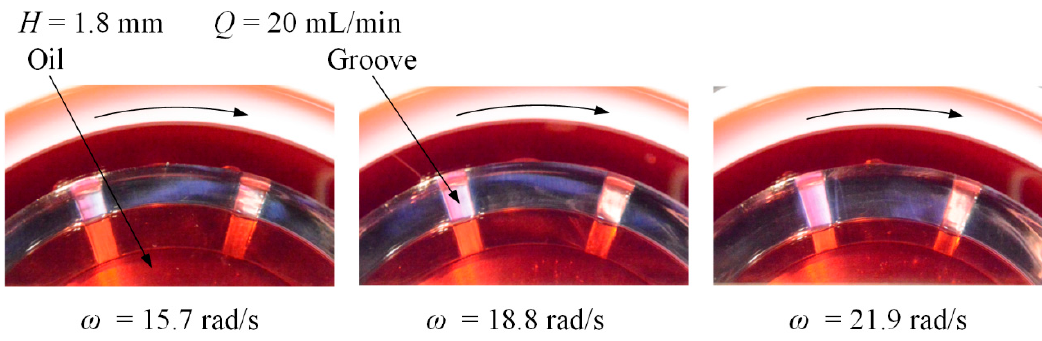
Figure 7. Comparison of the air–oil interface radial position at different angular velocities.